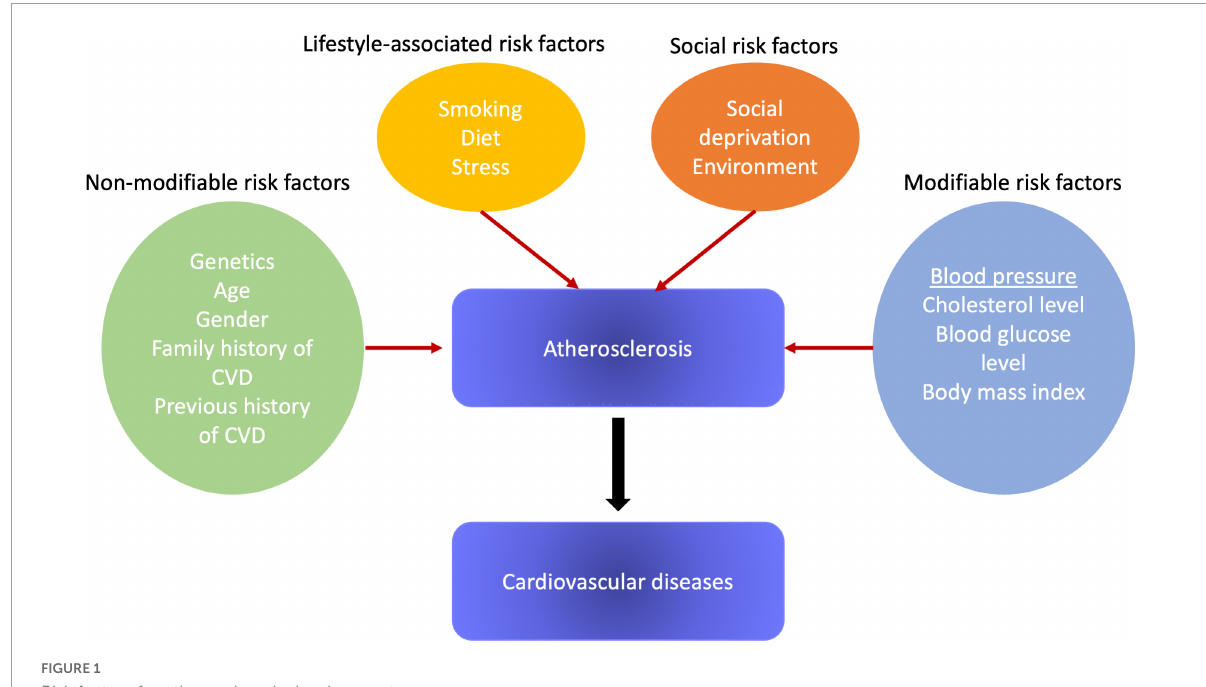
FIGURE1 Risk factors for atherosclerosis